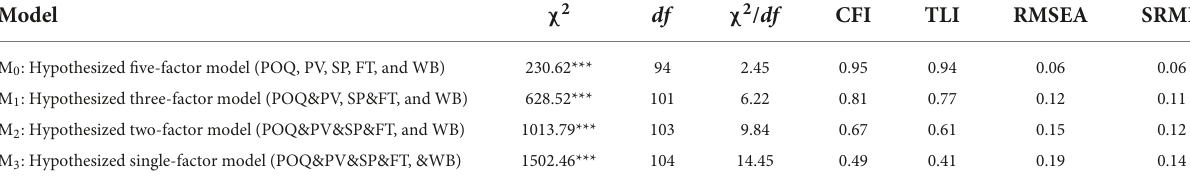
TABLE 1 Measurement model comparisons.